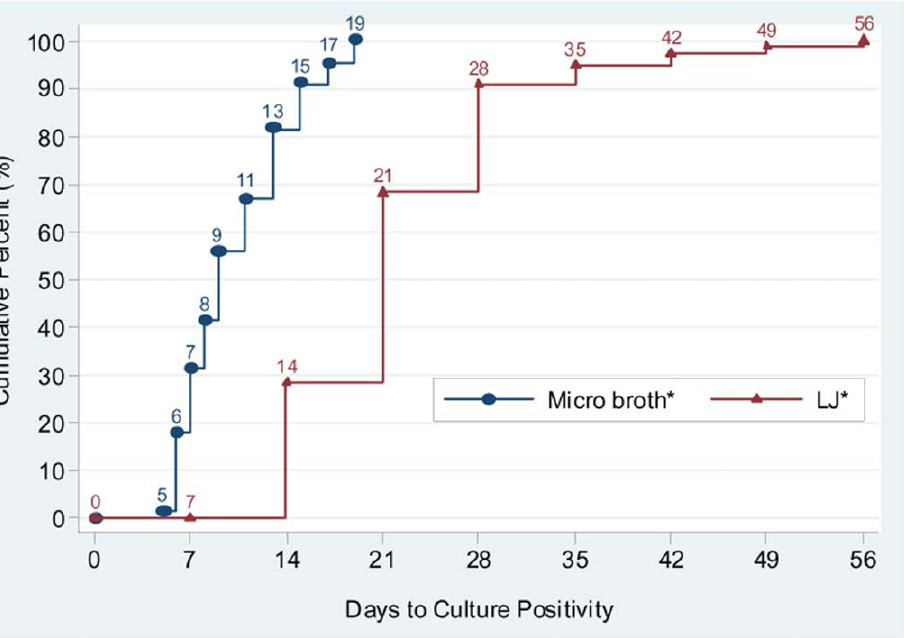
Figure 1. Time to positive culture for solid Lo¨wenstein–Jensen (LJ) versus liquid broth with microscopic detection. *The comparison of time to growth detection for paired 138 samples which were positive for both micro broth culture and LJ culture.